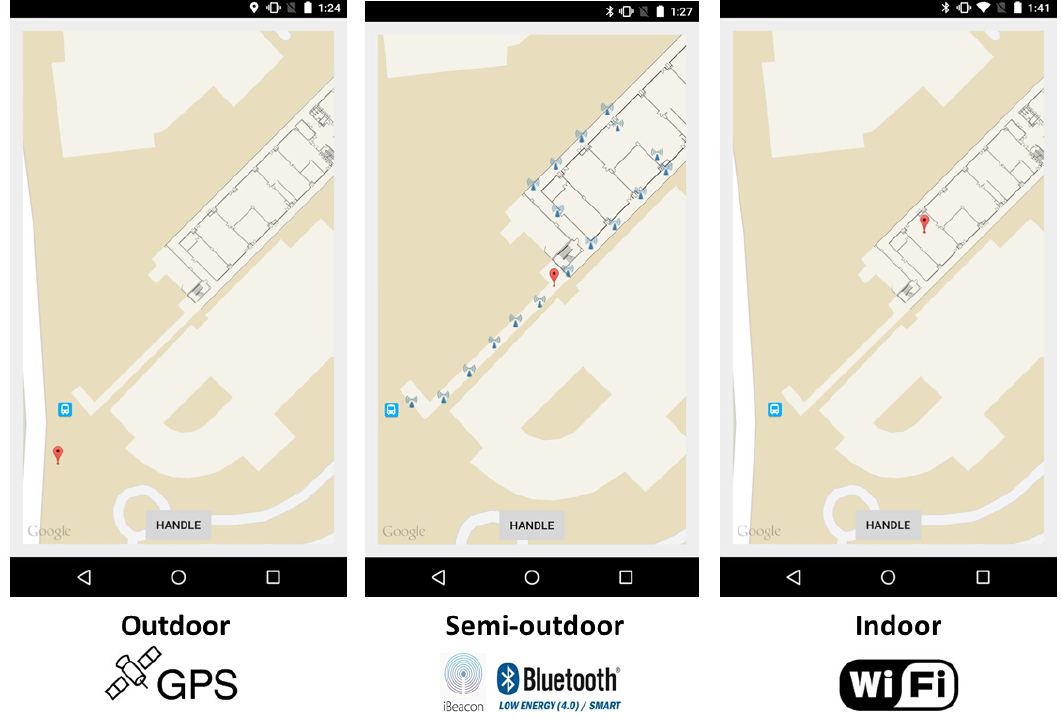
Figure 6. Screenshots of BlueDetect in the three environment